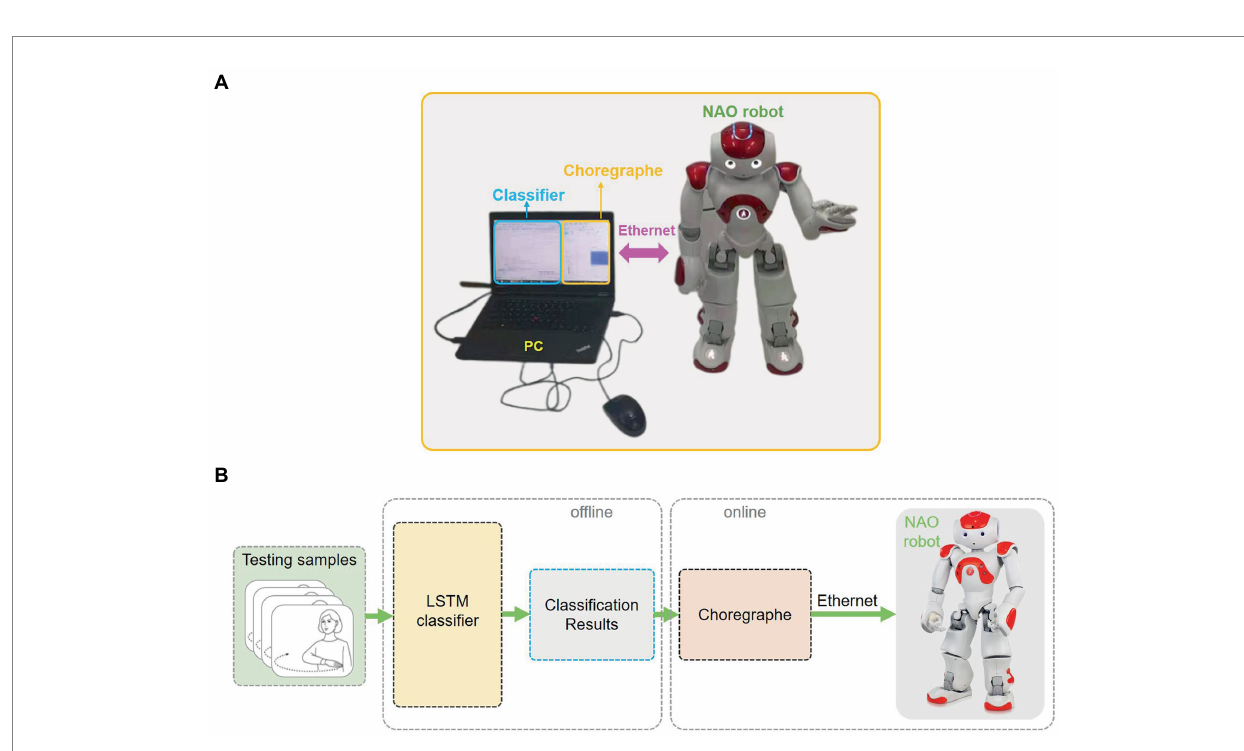
FIGURE 12 The experimental system of the second experiment. (A) The experimental platform of the second experiment. (B) The experimental steps of the second